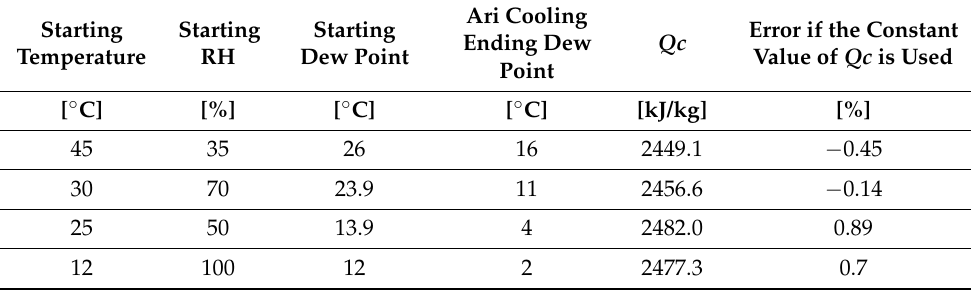
Table A3. Qc values calculated with numerical